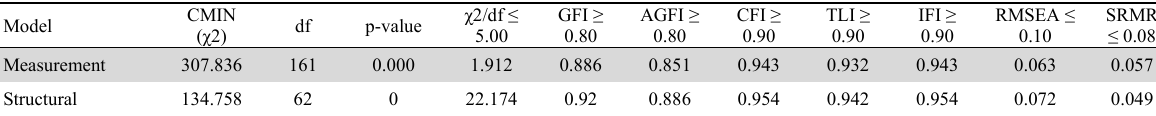
Structural Models and Goodness of Fit